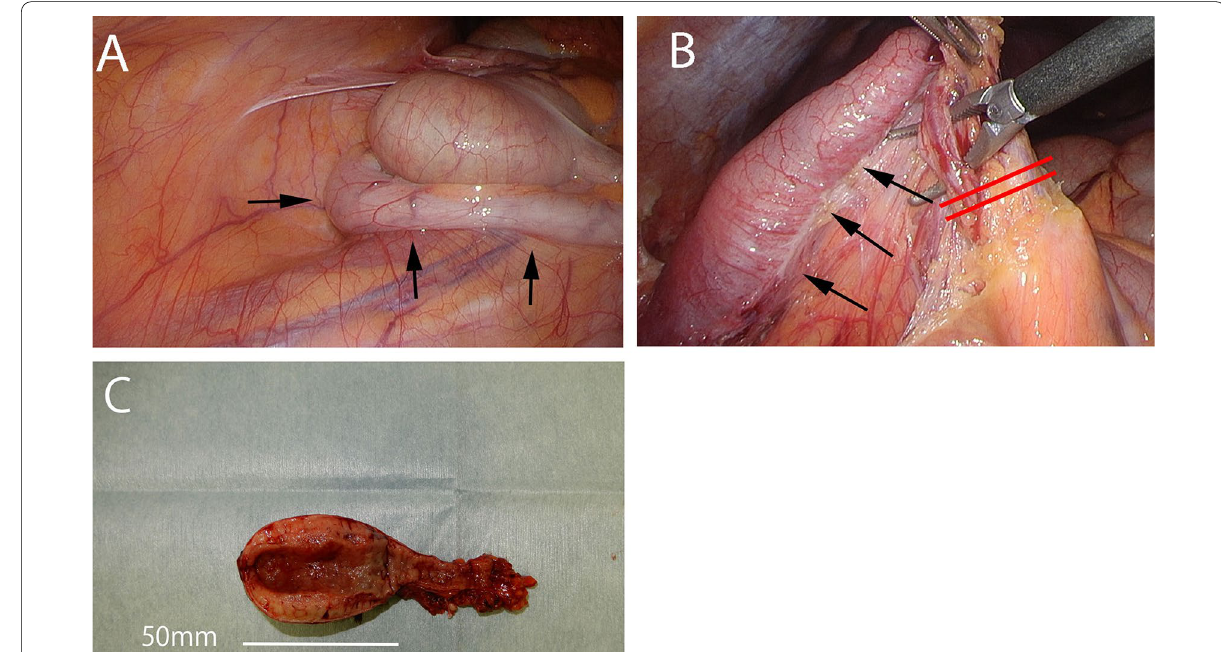
Fig. 2 A , B Appendix was located on the dorsal side of the cecum and was swollen (arrows). The appendix was cut off at the cecum with a linear stapler (red lines). C Extracted specimen showed thickening of the wall of the